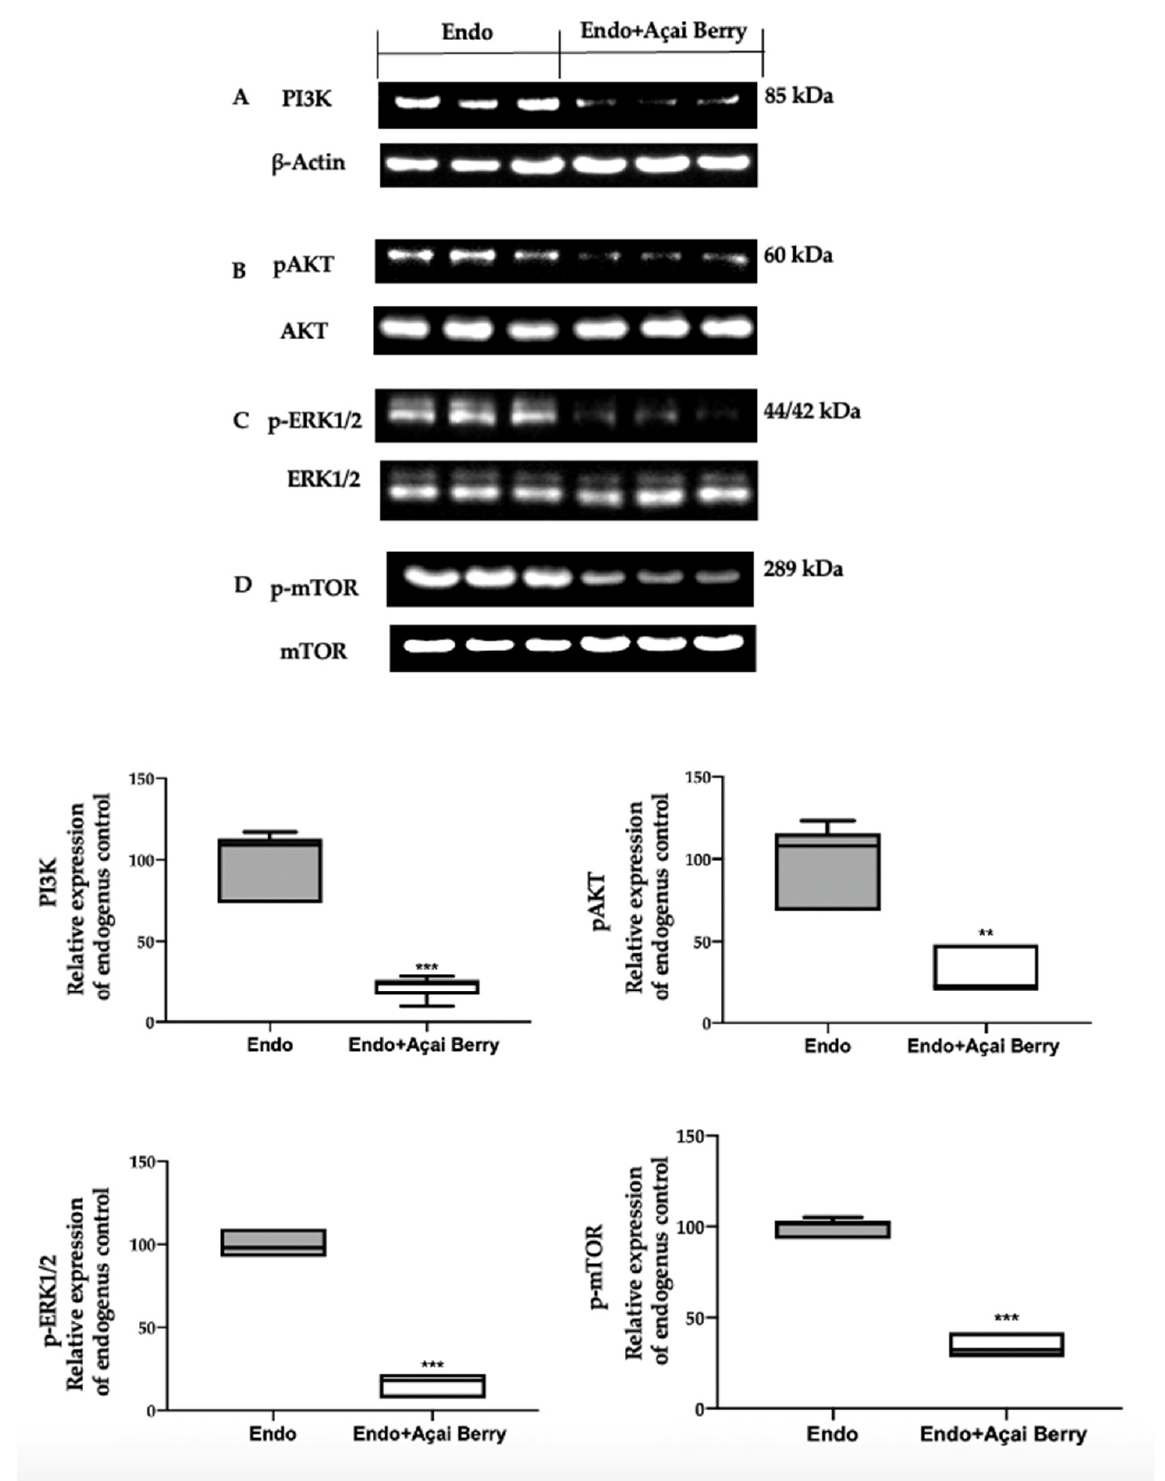
Figure 3. Analysis of Açai Berry administration on PI3K/AKT/ERK1/2 pathways. Western blot analysis of PI3K ( A ), pAKT ( B ), p-ERK1/2 ( C ) and p-mTOR ( D ) expression. A p-value of less than 0.05 was considered significant. ** p < 0.01 vs. Endo, *** p < 0.001 vs. Endo.